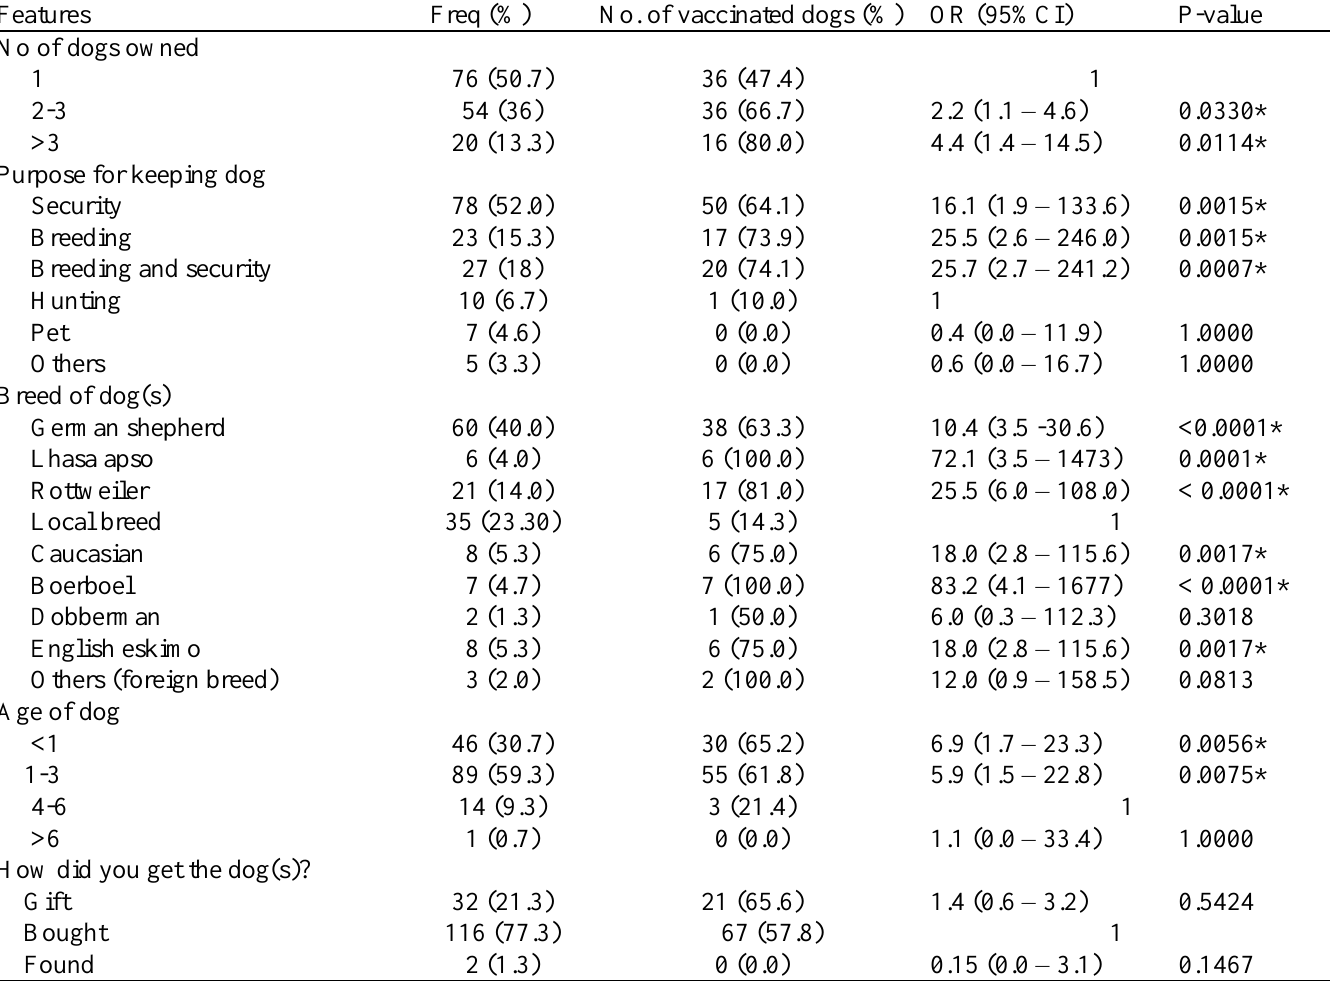
Table 2: Socio-demographic characteristics of dogs owned by